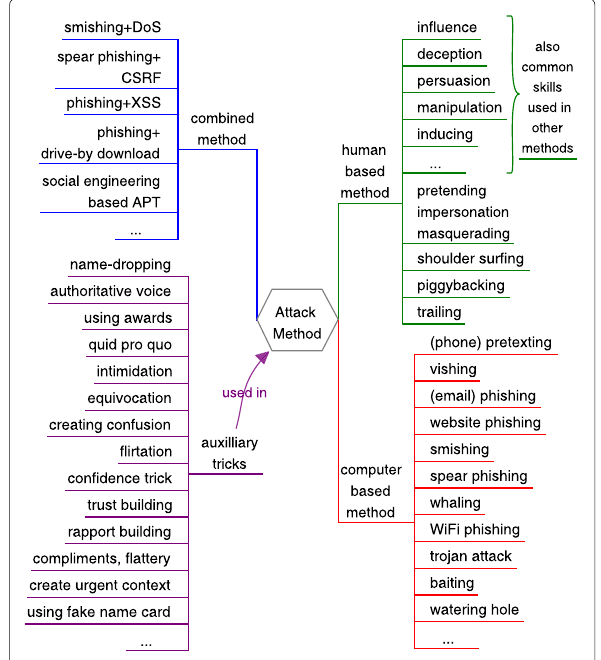
Fig. 10 Taxonomy of social engineering attack